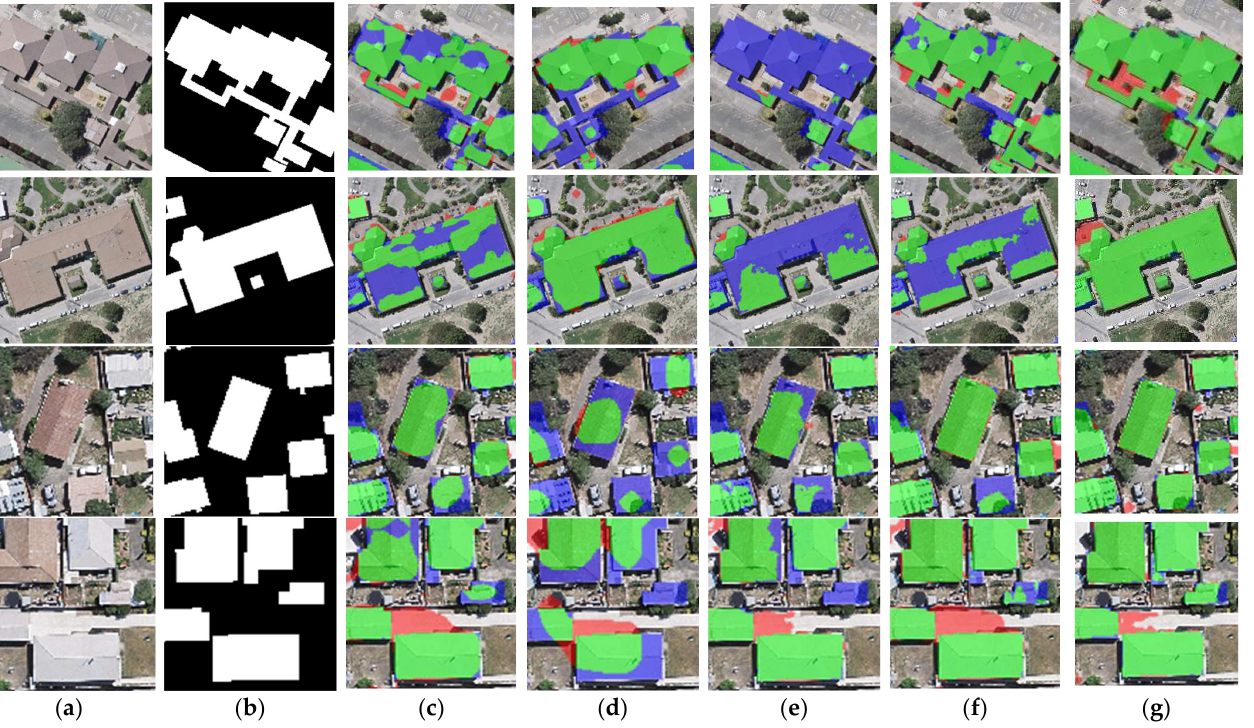
Figure 9. Close-up views of the results obtained by different networks on the WHU dataset. Images and results shown in ( a – g ) are the subset from the selected regions marked in Figure 7a. ( a ) Original image. ( b ) Ground-truth. ( c ) FCN8s. ( d ) DANet. ( e ) SegNet. ( f ) U-Net. ( g ) BGC-Net. Note, in Columns ( b – g ), black, white, green, blue, and red indicate true, false, true-positive, false-negative, and false-positive, respectively.